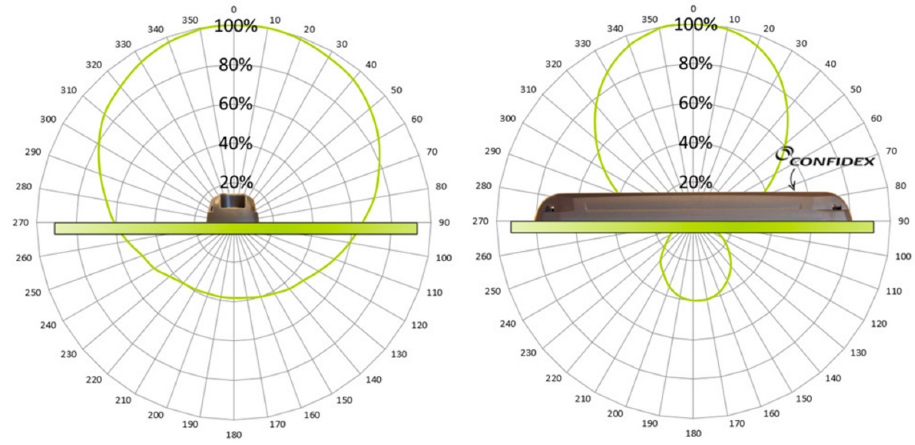
Figure 2. Radiation patterns of Confidex Survivor RFID Tag according to the datasheet